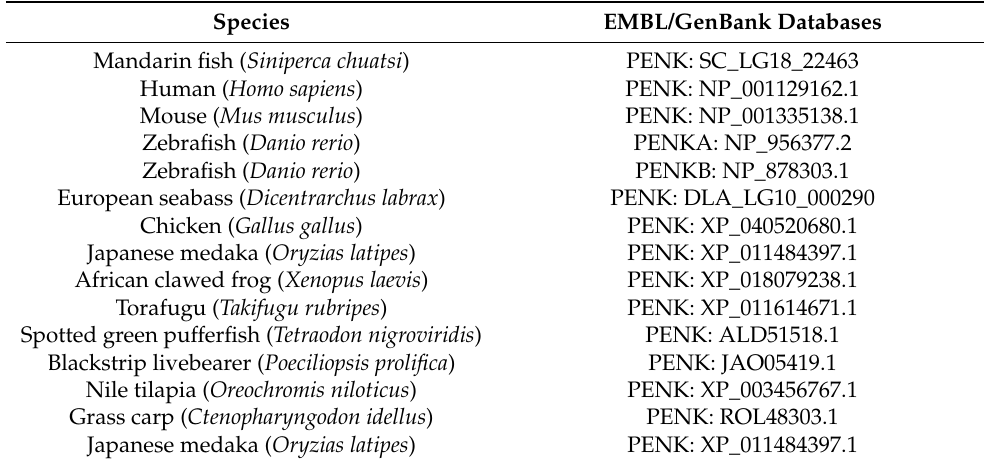
Table 1. The accession numbers of PENK amino acid sequences of different